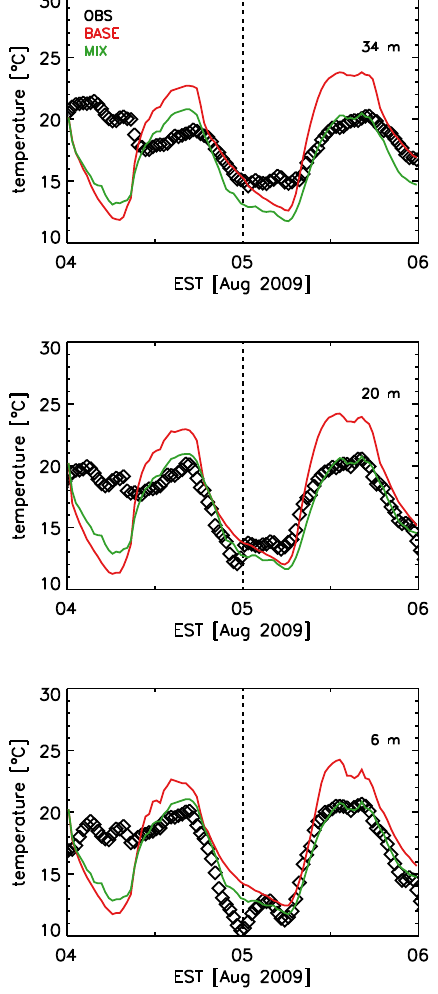
Fig. 3. Measured and modeled temperatures at 34, 20.4, and